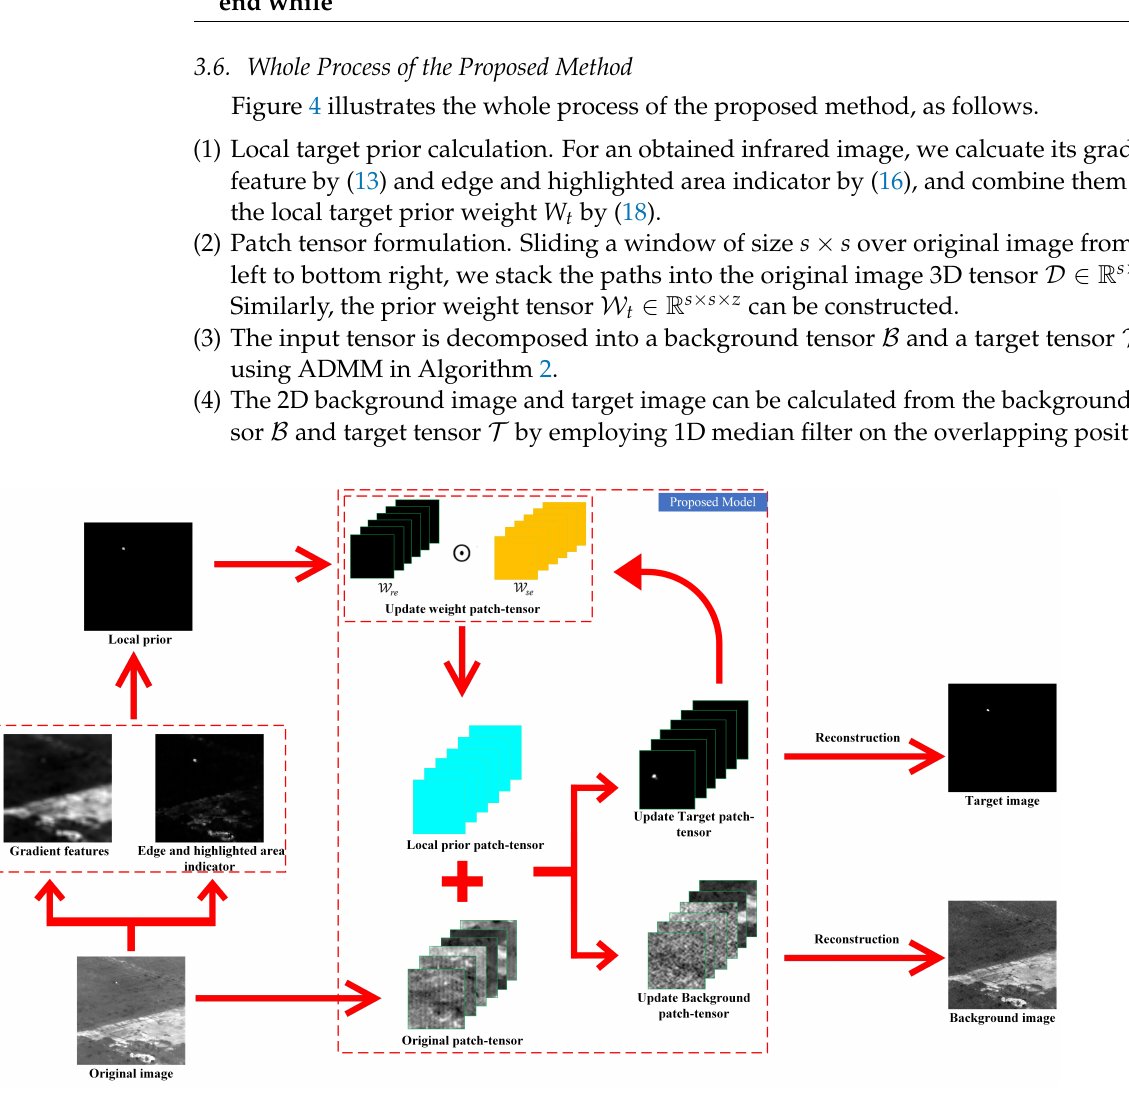
Figure 4. Procedure of the proposed